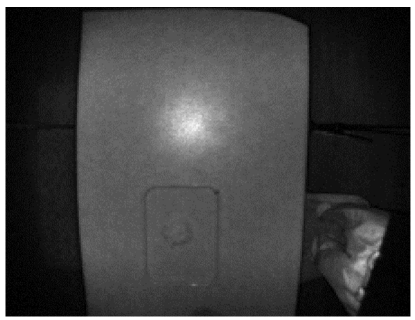
Figure 7. Grayscale image capture by the Pico Flexx camera.